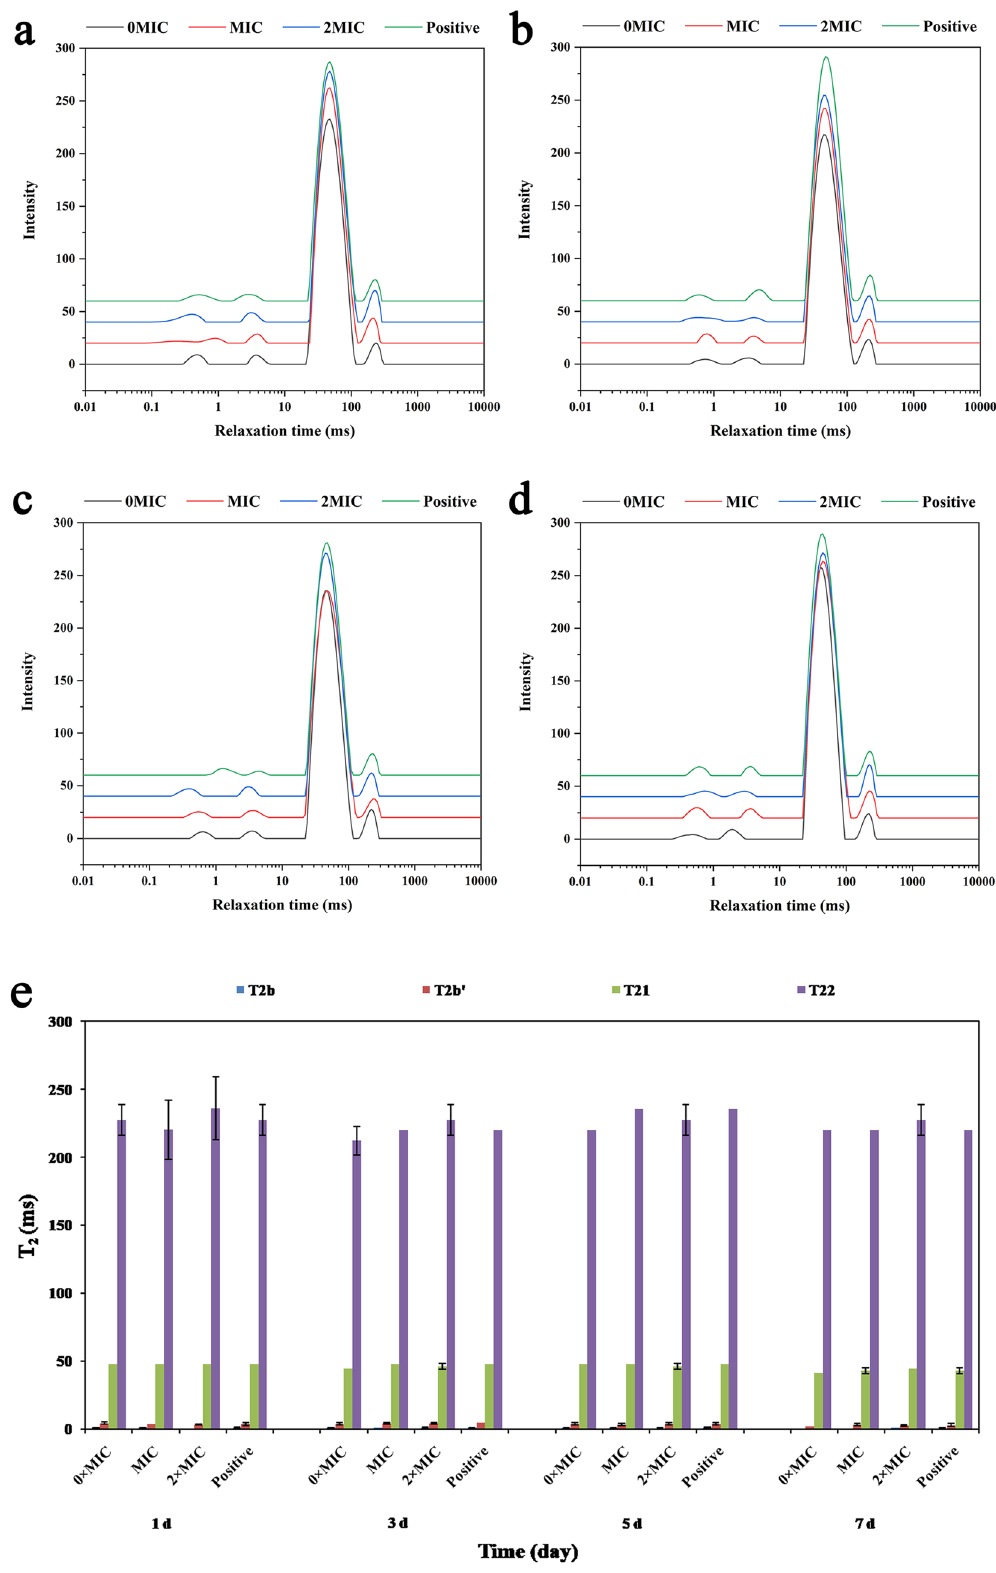
Figure 5. LF-NMR T 2 relaxation time distribution curves for pork supplemented with PCA during different storage periods. ( a ) 1st, ( b ) 3rd, ( c ) 5th, and ( d ) 7th day. ( e ) The effect of PCA on pork water relaxation time ( T 2 ) during different storage periods. Error bars represent the standard deviation (n =